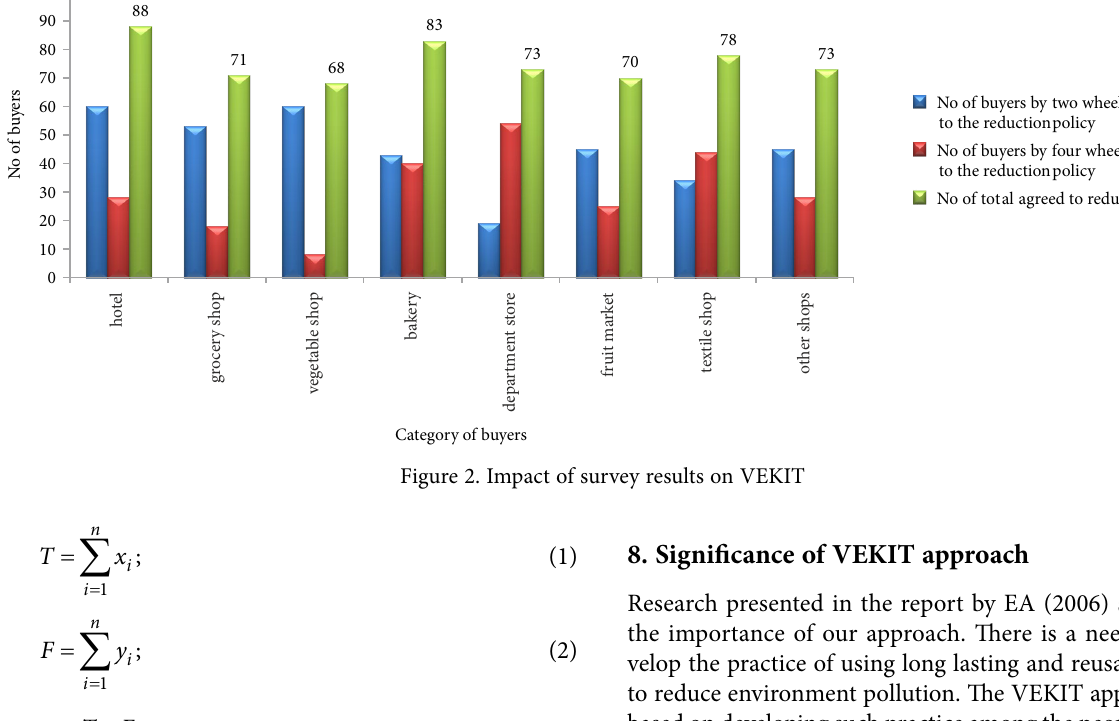
Figure 2. Impact of survey results on